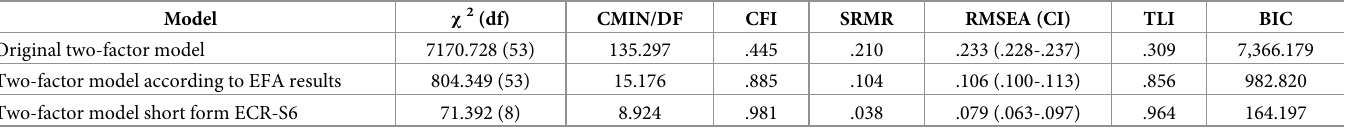
Table 5. Summary of fit indices of different factor models.